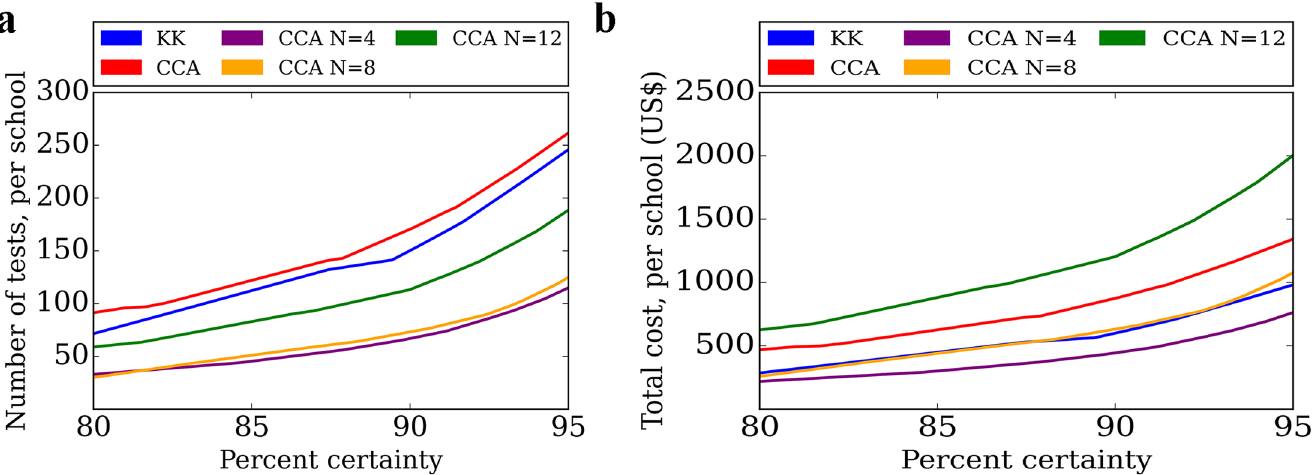
Fig 3. Number of tests and total costs per school from microsimulation analysis of urine pooling strategy and traditional stool microscopy. The urine pooling strategy (n = 4, 8, and 12 pool) was compared against stool microscopy to estimate (a) the total number of tests per school and (b) total cost per school for identical level of certainty in binary classification on need for preventive chemotherapy. We used a 10% prevalence threshold in this base case analysis. A loess algorithm was applied for visualization.